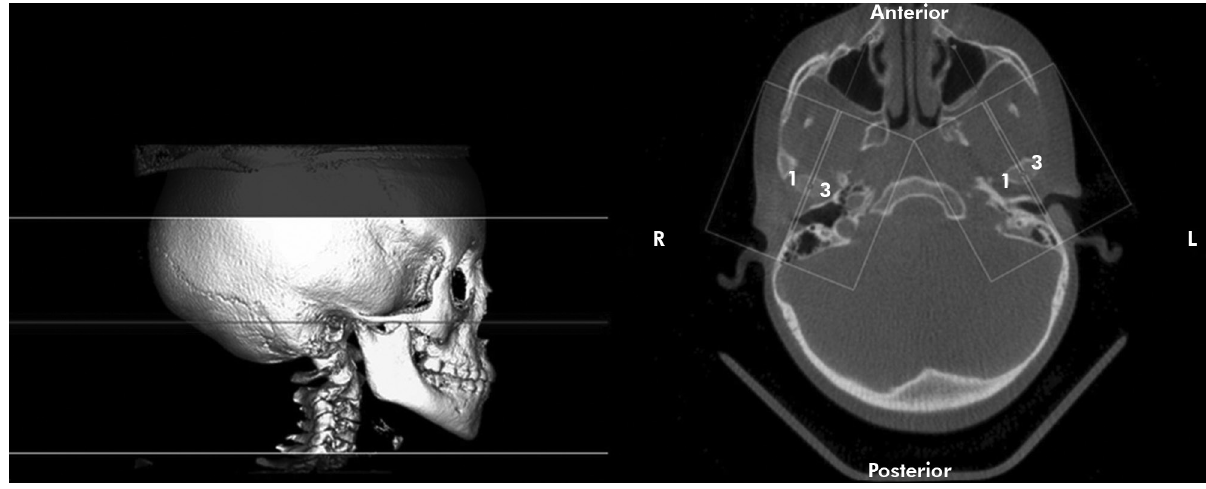
Figure 2. Cuts Orientation – Software Dolphin 3D ® (Dolphin Imaging/Patterson Dental, Chatsworth,